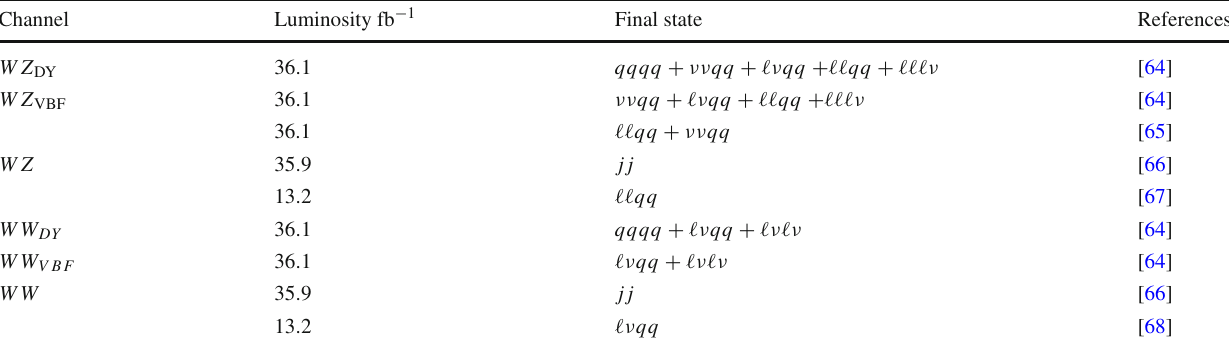
showswhatistheintegratedluminosityofthedatasampleusedtoderive the bound. The third column indicates the final states through which the given channel was observed. The bounds were provided by the ATLAS and CMS Collaborations in the papers referred to in the last column